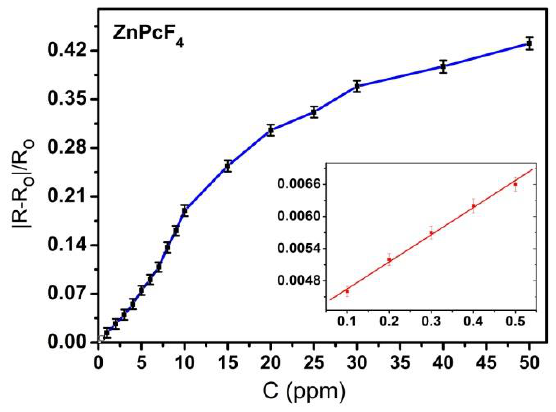
Figure 8. Dependence of the sensor response of ZnPcF 4 films on NH 3 concentration (0.1–50 ppm).